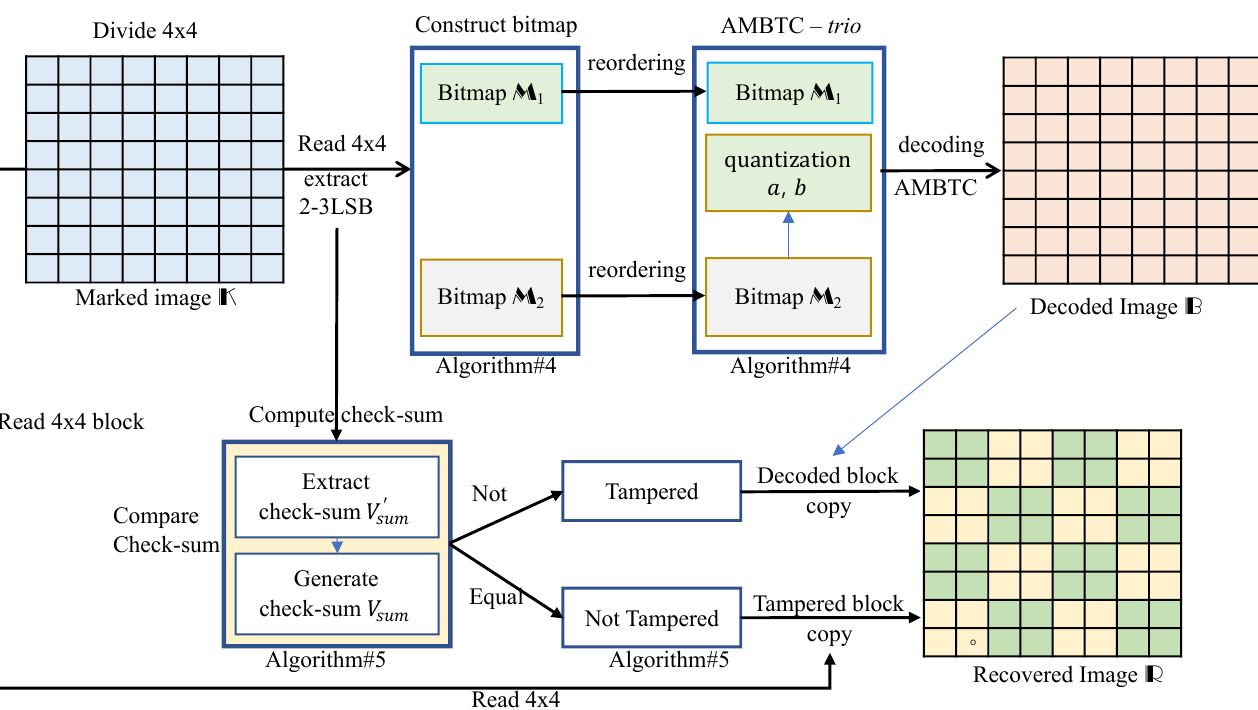
Figure 3. Block diagram for watermark extraction, tampering detection, localization and image recovery (See Algorithms 4 and